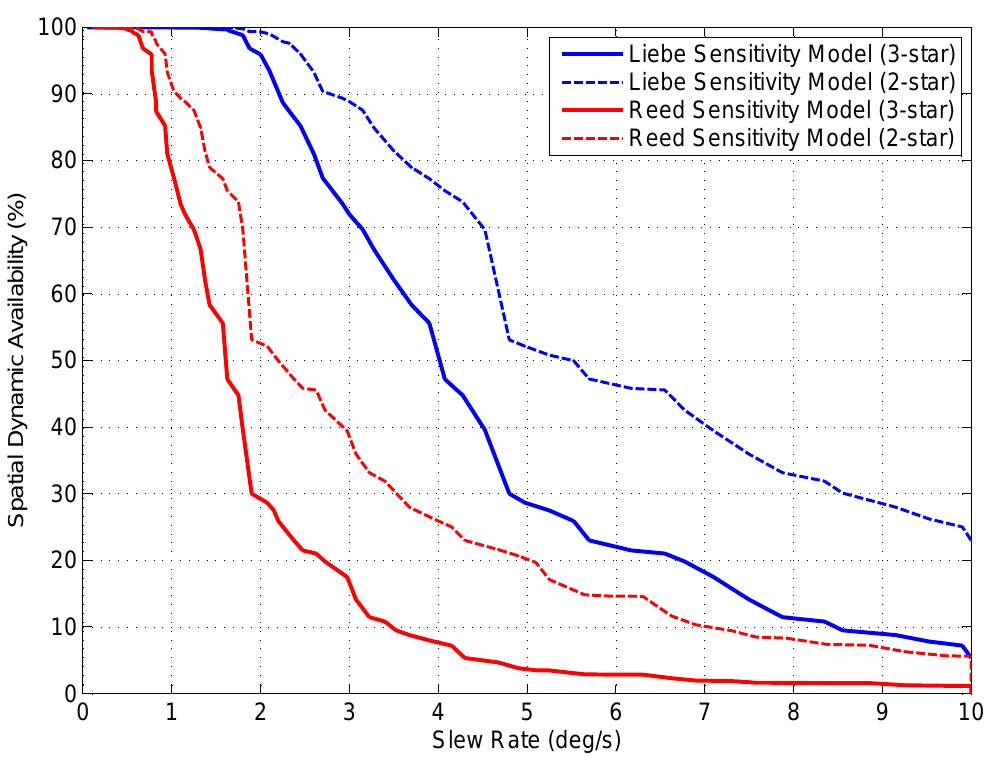
Figure 11. ST-16 spatial dynamic